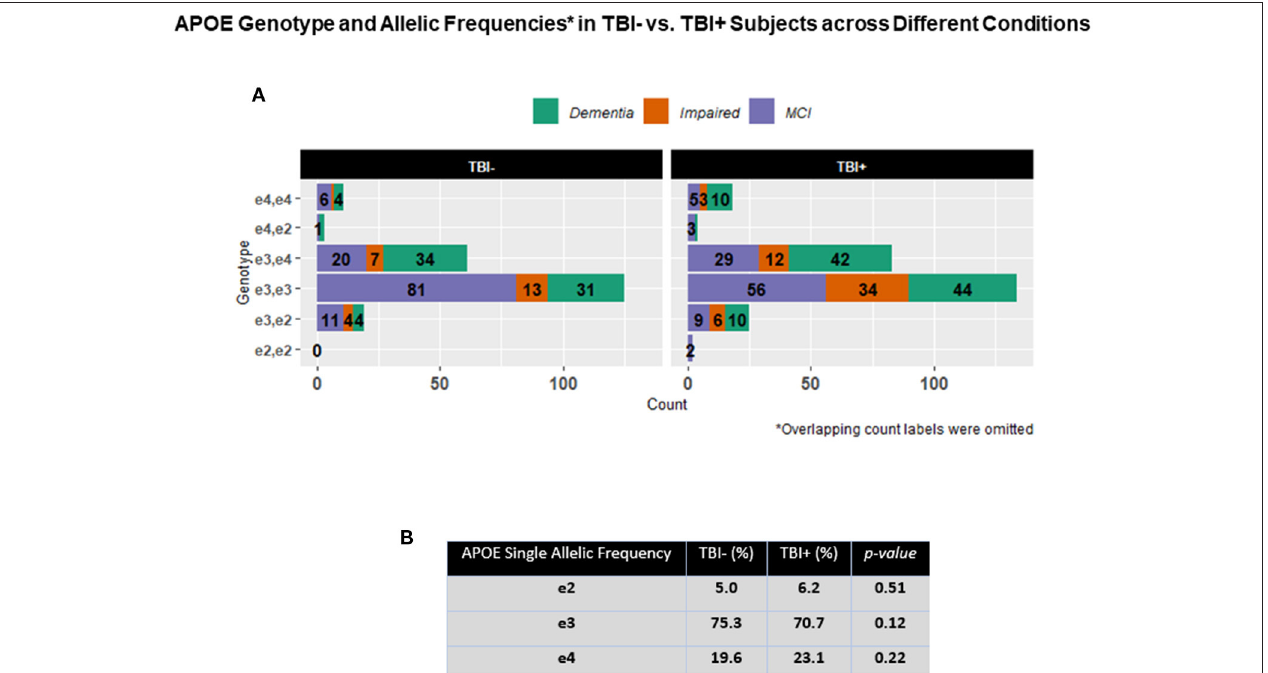
FIGURE 3 | (A) The figure shows horizontal stacked bars for the description of the relative frequencies of the different APOE in both TBI + (subjects with a previous history of TBI at the time of their first cognitive decline assessment) and TBI– (subjects without a previous history of TBI at the time of their first cognitive decline assessment) as clustered by their associated clinical diagnosis at the time of their first cognitive decline assessment. MCI: Mild cognitive impairment, Dementia [including Alzheimer’s disease (AD), Dementia with Lewy bodies (DLB), Progressive supranuclear palsy (PSP), Corticobasal degeneration (CBD), Frontotemporal Dementia (FTD), Vascular dementia (VaD), Traumatic brain Injury (TBI), normal pressure hydrocephalus (NPH), Depression, Cognitive decline due to systematic disease or medical illness], non-AD Impairment (Impaired). (B) The table in the figure shows the general APOE allelic frequencies (APOE2, E3, E4) in both TBI + and TBI– subjects in the analyzed NACC’s TBI cohort.